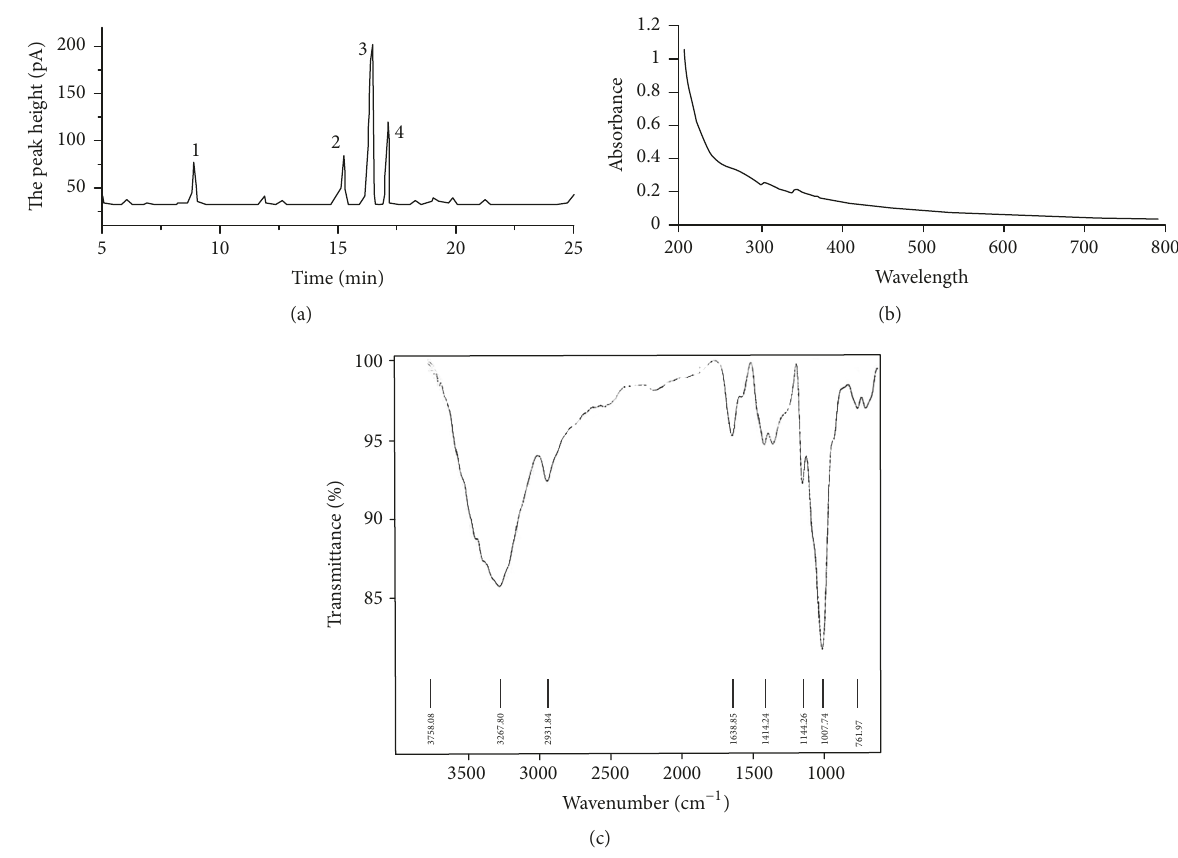
Figure 4: Gas chromatography, UV-visible spectra, and FT-IR spectrum of JP1.